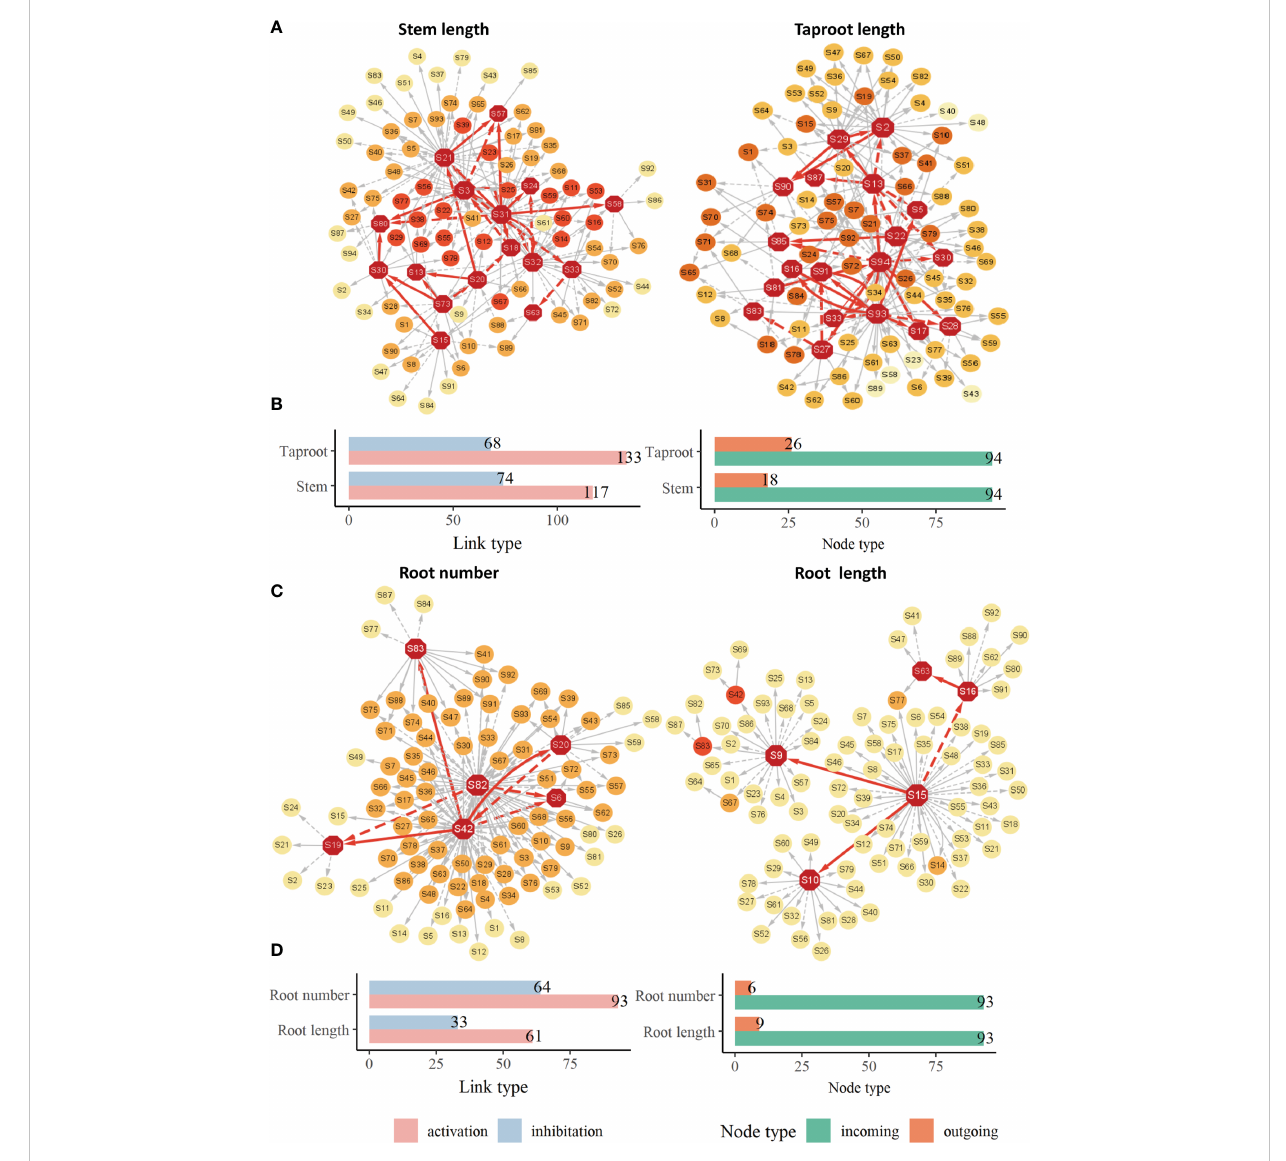
FIGURE 5 Genetic effect networks (A) , bar chart for activating links and inhibitory links and bar chart for outgoing nodes and incoming nodes in networks (B) for stem length and taproot length. Genetic effect networks (C) , bar chart for activating links and inhibitory links and bar chart for outgoing nodes and incoming nodes in networks (D) for root number and root length. Each node represents a QTL. The edges connecting nodes represent the interaction among QTLs, the dotted links represent the inhibitory effect, the solid links represent facilitation. The red nodes represent QTLs that stimulate or inhibit other